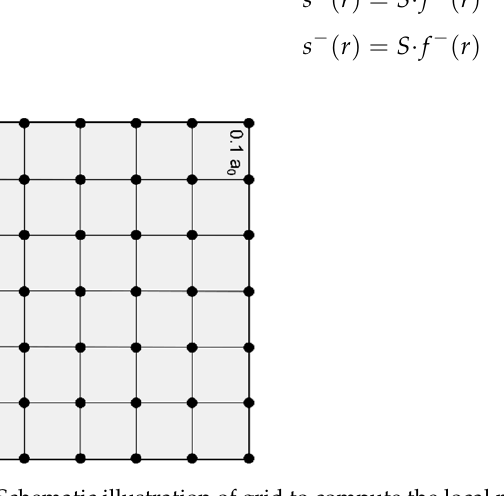
Figure 9. Schematic illustration of grid to compute the local monomer descriptors. In these equations, f ( r ) represents the corresponding Fukui function at each grid point, which itself is defined as in Equations (10)–(12), with ρ x ( r ) the electron density of the x = N , N − 1 or N +1 electron